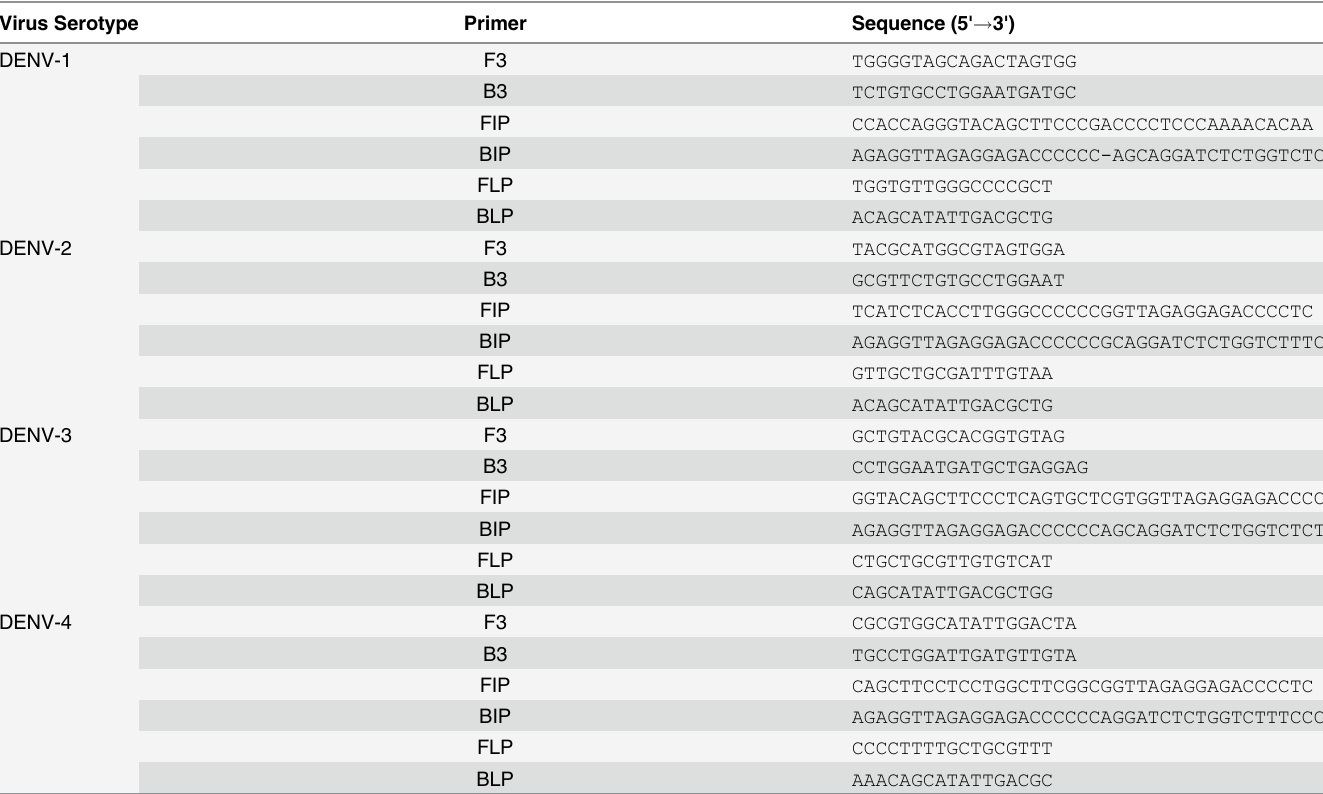
Table 1. RT-LAMP Primers used in this